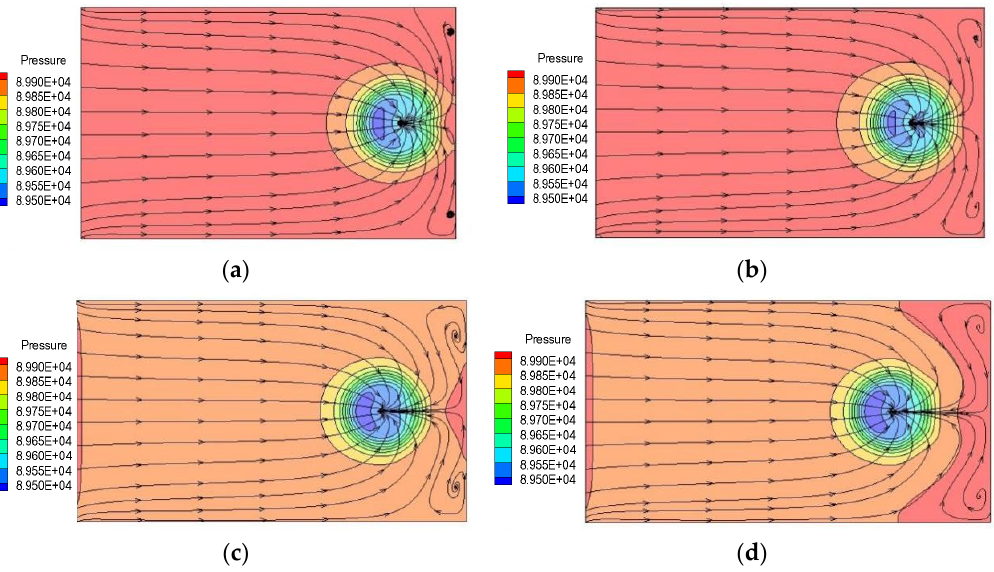
Figure 16. Pressure distribution of section 2-2 with different back wall distance. ( a ) Case 8, ( b ) Case 6, ( c ) Case 9 and ( d ) Case 10.